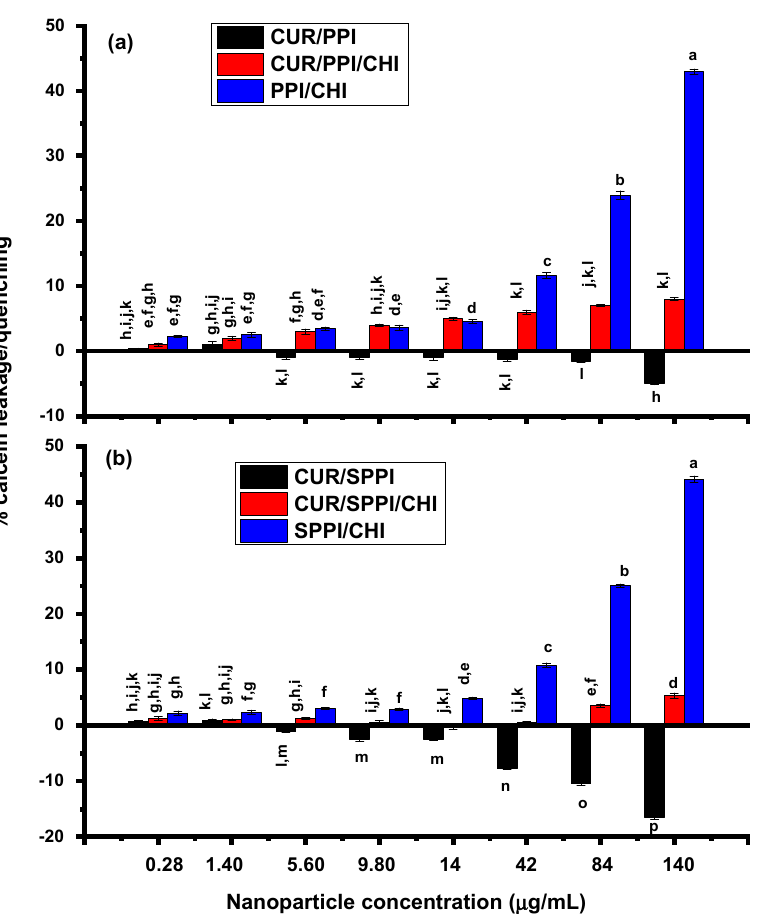
Figure 2. Percentage calcein leakage from the GUV, induced by ( a ) native protein-based nanoparticles and ( b ) succinylated protein-based nanoparticles, with different surface chemistry and physicochemical properties. Bars with similar letters represent mean values that are not significantly different at p < 0.05.